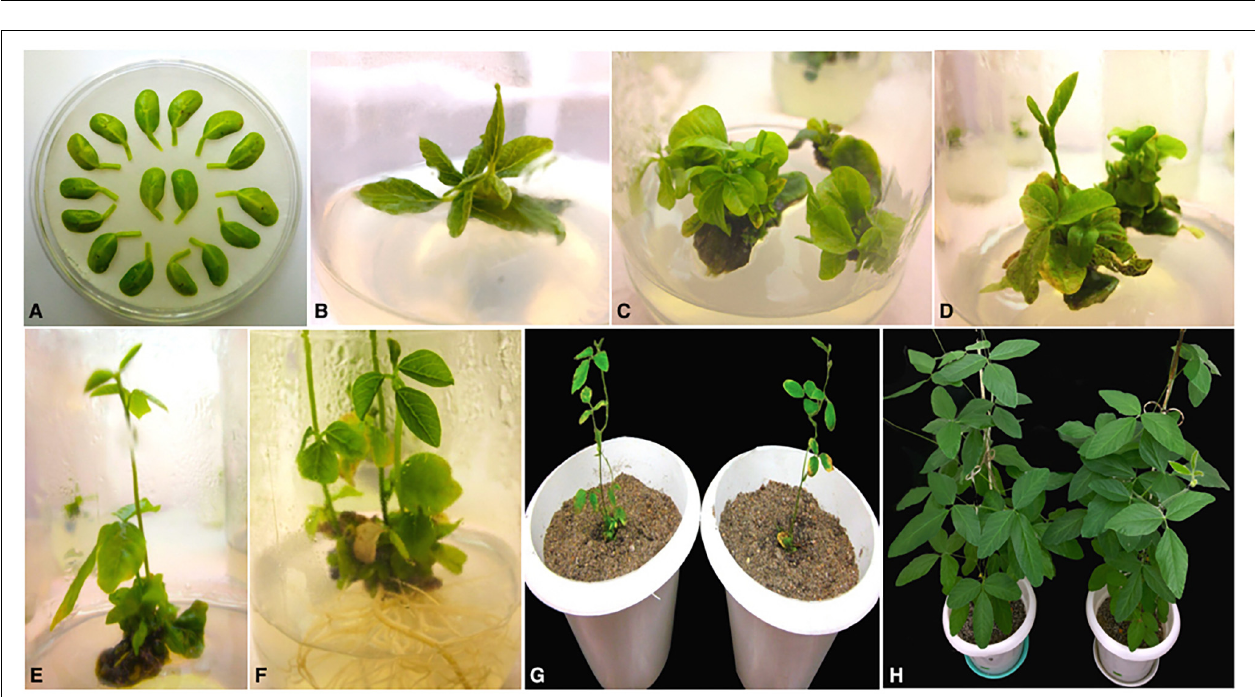
FIGURE 2 | Different stages of Agrobacterium -mediated cotyledonary-node transformation of soybean cv. Pusa 16. (A) Co-cultured wounded cotyledonary-node explants (B) shoot induction from axillary meristem on SIM after 2 weeks; (C) shoot development with 4 mg/l glufosinate selection on SIM after 4 weeks of culture; (D) shoot elongation with 5 mg/l glufosinate selection on SEM after 6 weeks of culture; (E) elongated, glufosinate-resistant shoot ready for transfer to RM after 9 weeks of culture; (F) root development on RM; (G) acclimatization of plantlets in sterilized pot mix; (H) mature T 0 transgenic plants.